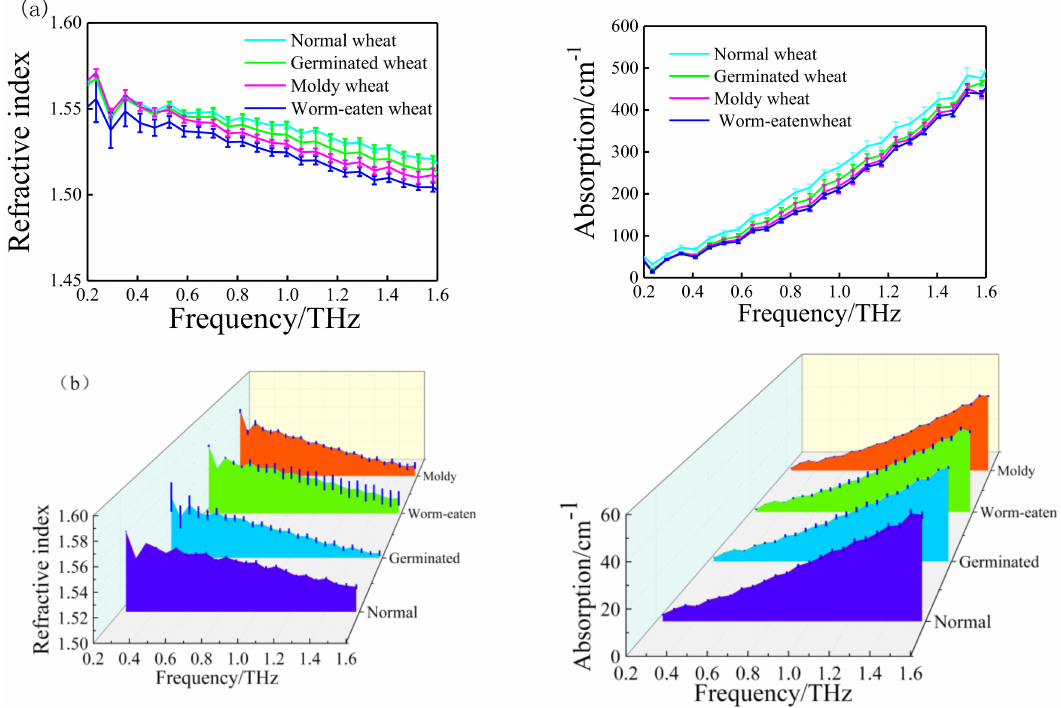
Figure 3. Refractive index spectra and absorption spectra ( a ) of different wheat samples and waterfall plot ( b